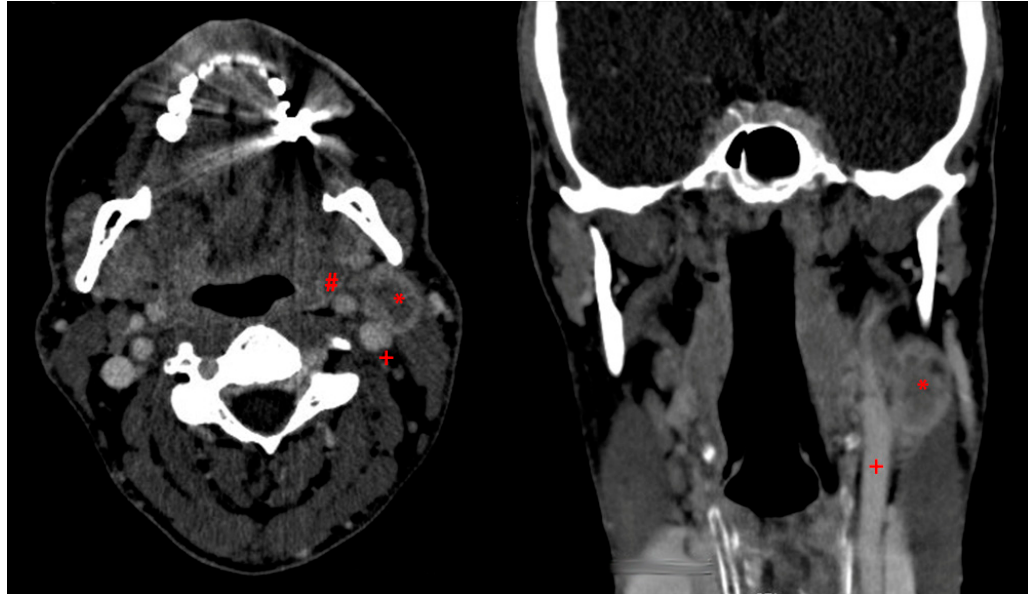
Figure 1. Axial (left) and coronal (right) cross sectional radiographic images of a lymph node metastasis (*) of the left cervical level IIb of a 38 years old male patient suffering from an advanced squamous cell carcinoma of the oral cavity at retromolar region (UICC stadium IVa). Primary carcinoma has been surgically removed with a surrounding safety margin. Due to the metastasis´ closeness to the vascular wall of the arteria carotis interna (#) and externa (+), a surgical removal could not be performed with a safety distance. Biopsy testing for the presence of possible remaining tumour cells at the vascular wall could not be performed. So, possible remaining tumour cells can be the reason for tumour recurrence or metastasis.